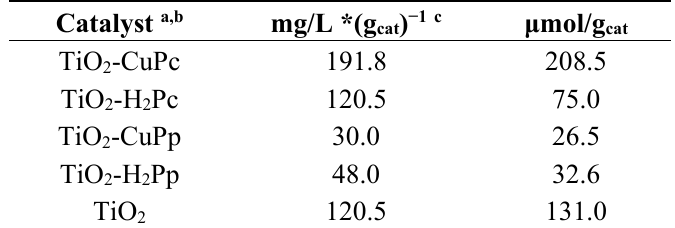
Table 6. Comparison between the photoactivity of phthalocyanine/TiO 2 and porphyrin/TiO 2 samples at pH =